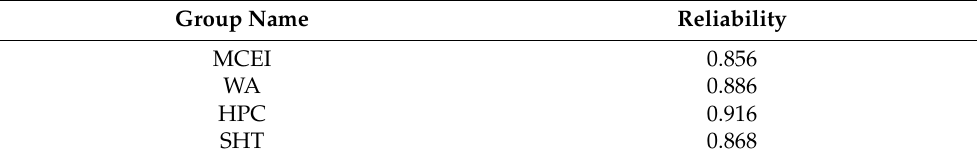
Table 6. Reliability